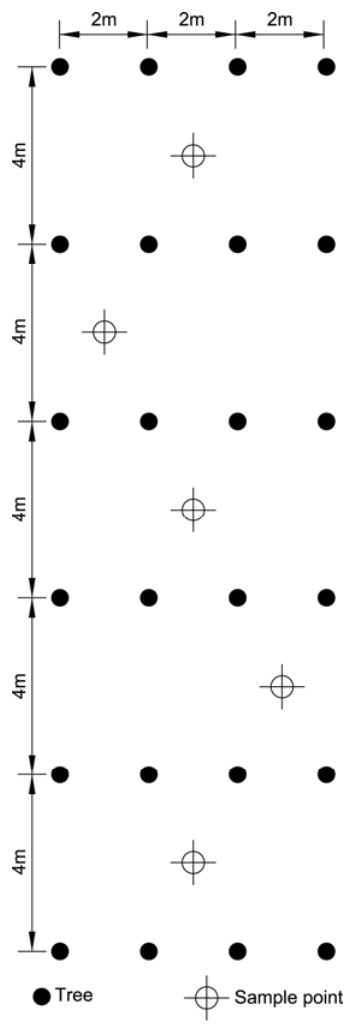
Figure 1. Setting of soil moisture sampling.